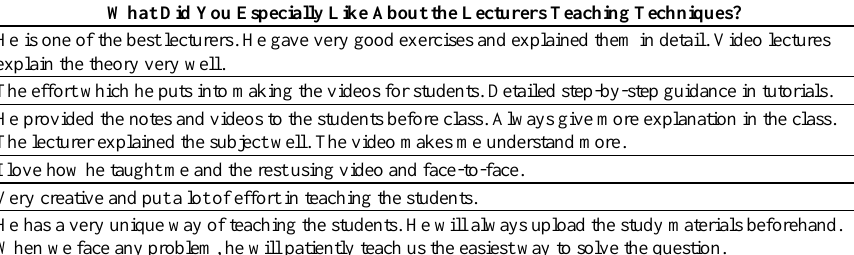
Table 1. Some selected comments by the students on the flipped classroom